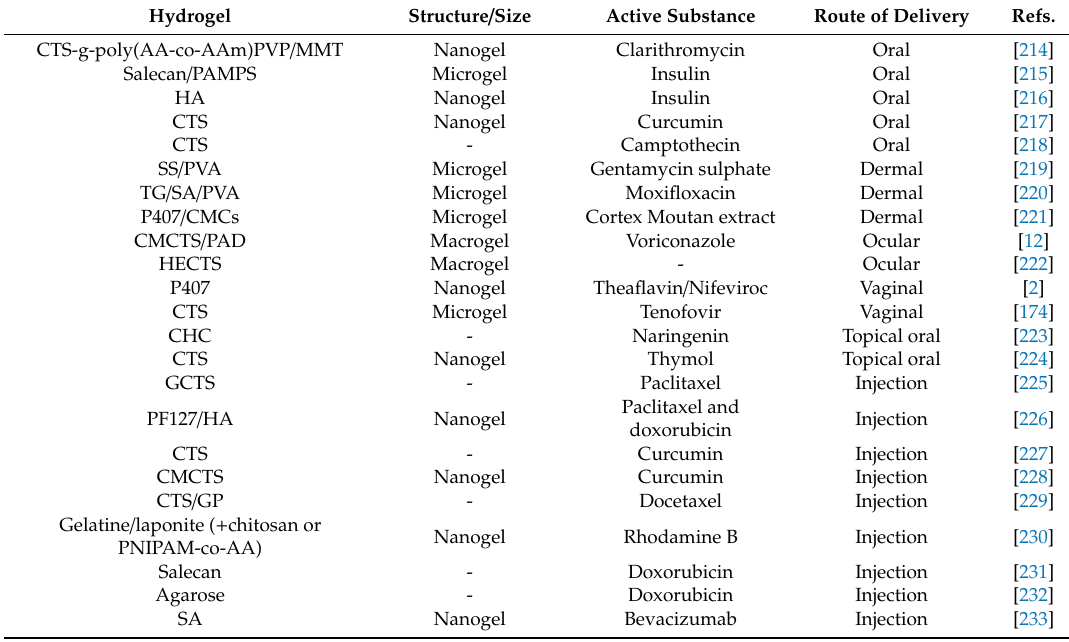
Table 3. Summary of HGs that can be used as drug